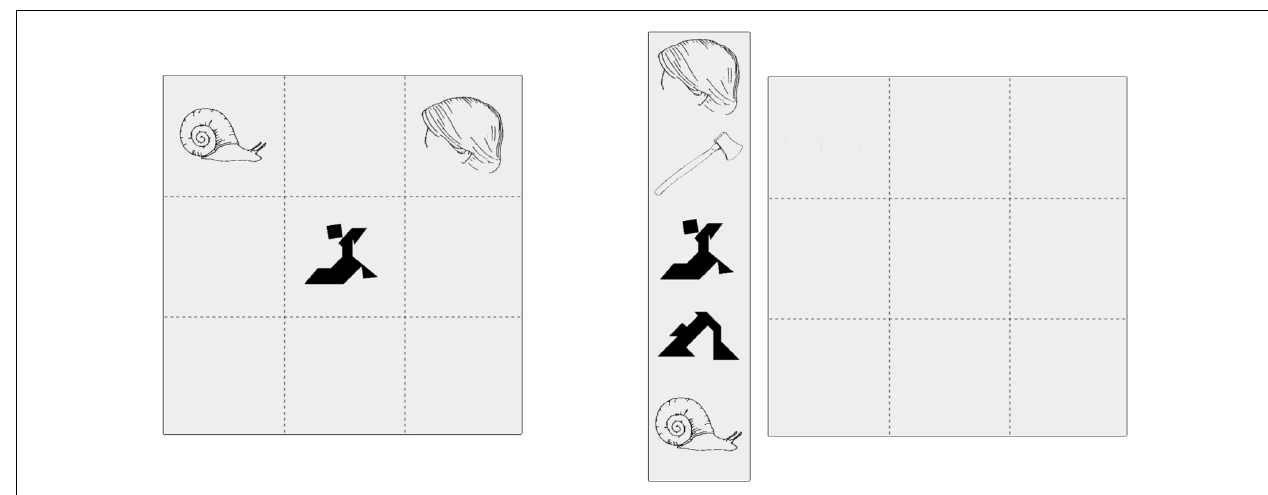
FIGURE 1 | Example director’s grid (left) and corresponding matcher’s grid